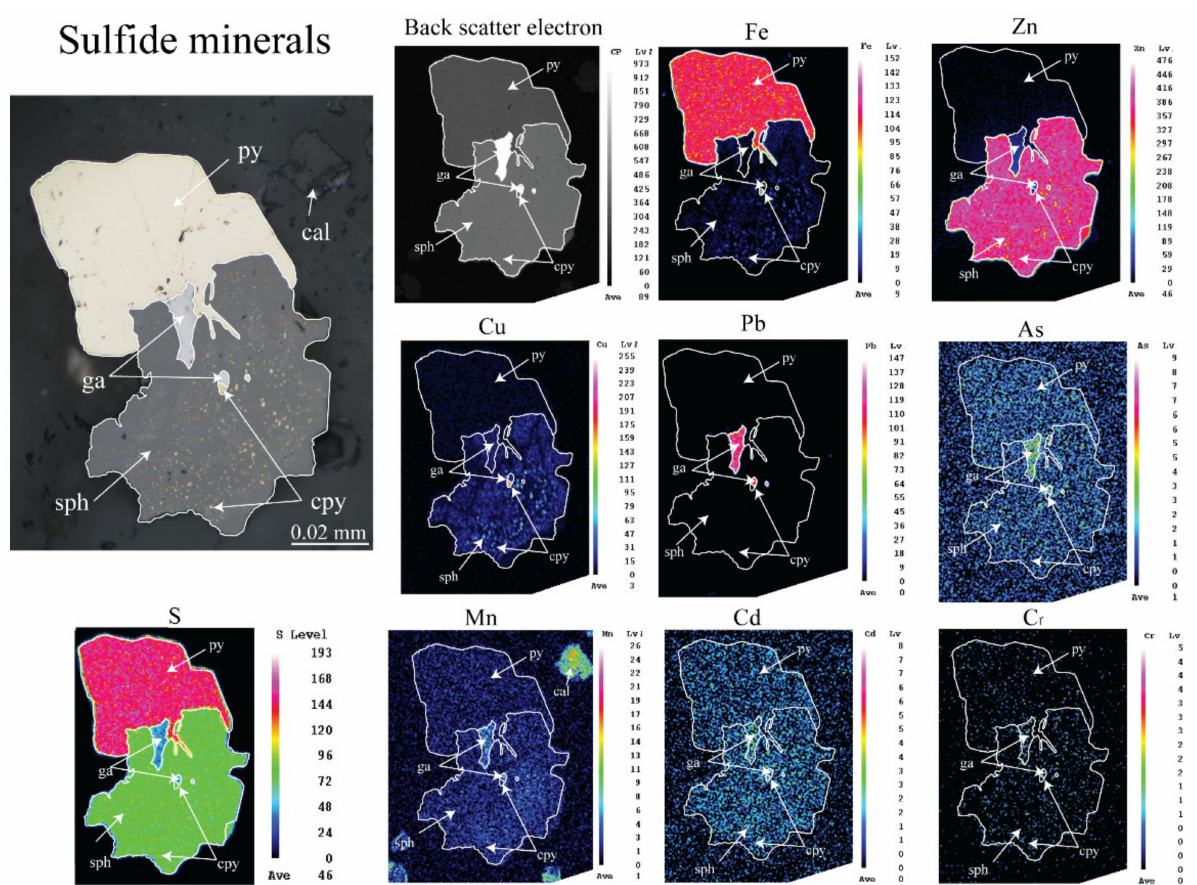
Figure 6. Photomicrograph, back scatter electron, and EPMA elemental map images of aggregated sulfide minerals in the quartz-carbonate-chlorite-sulfide-electrum vein (stage 3). Abbreviations: py = pyrite, cal = calcite, sph = sphalerite, cpy = chalcopyrite, ga =